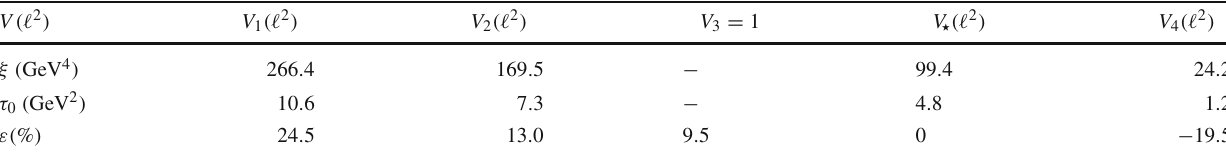
Table 1 The values of the parameters ξ and τ 0 used in (5.9) in order to obtain the V i ((cid:7) 2 ) shown in Fig. 4. The tree-level case, V 3 = 1, is recov- ered by simply setting λ s = 0. In the last row we quote the percentage